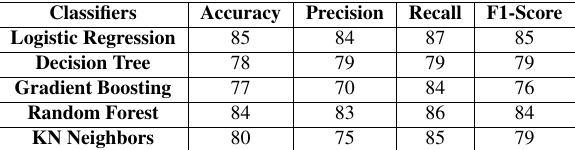
Table 1: Tabular comparison of the classifiers (in %)